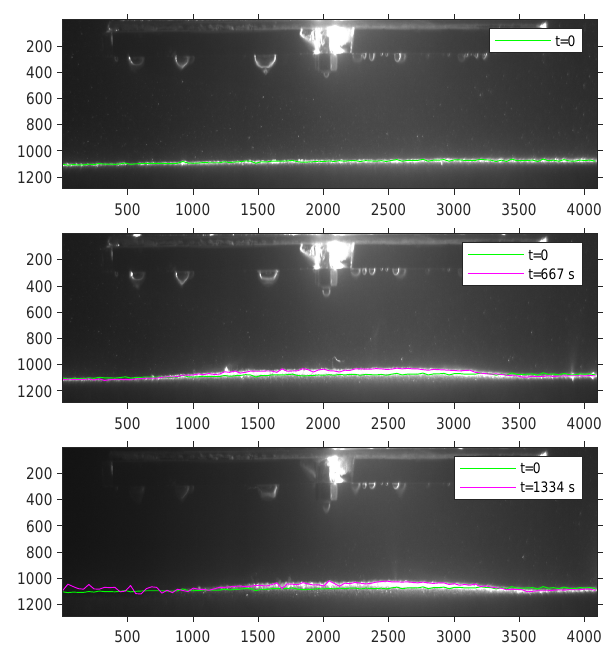
Fig. 4 : Run n.166, both the axes are in pixel (where 1800 pixels correspond to 10 cm